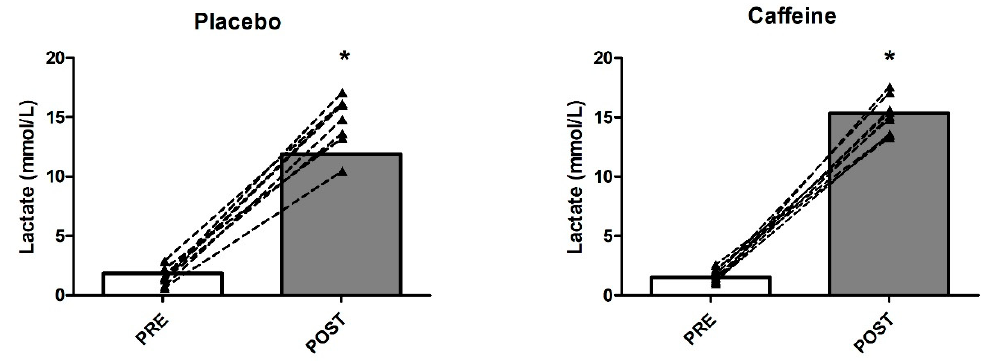
Figure 2. Blood lactate concentrations pre-post Wingate. * p < 0.05, significant di ff erences compared to pre-Wingate values